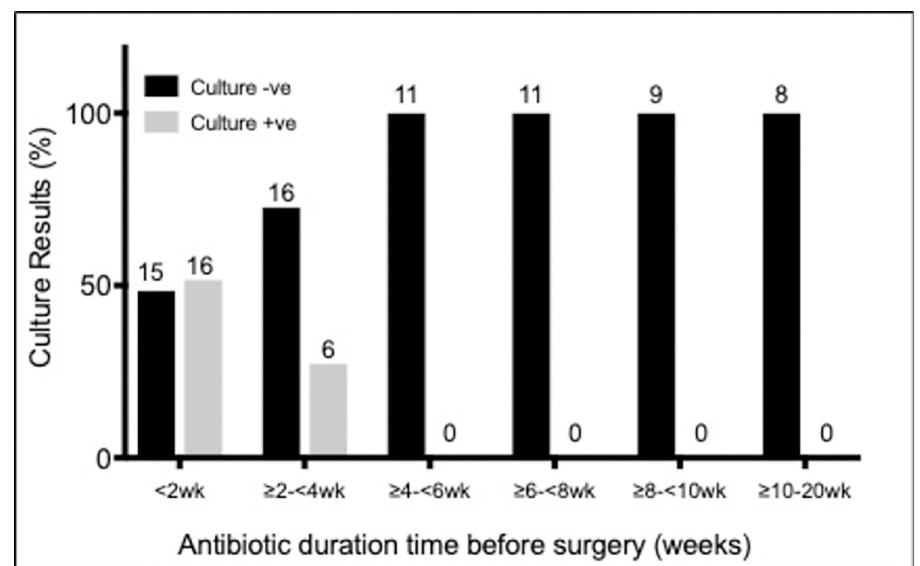
Fig 1. Relationship between antibiotic duration before surgery (weeks) and culture results. Figure labels on columns represent actual number of cases.